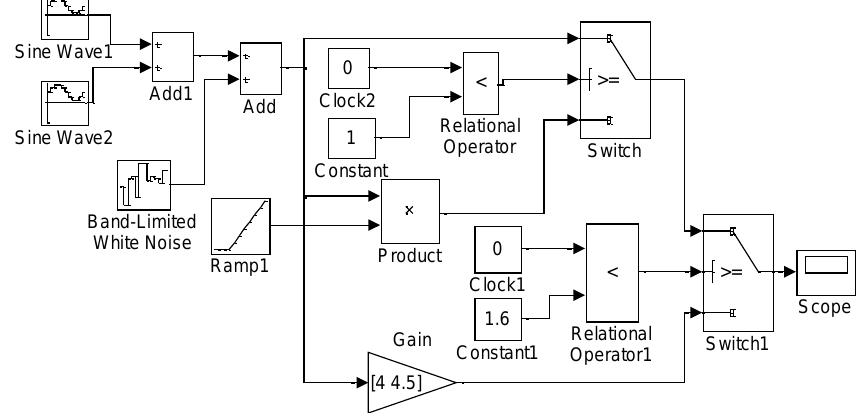
Figure 2. Grinding chatter signal generator.